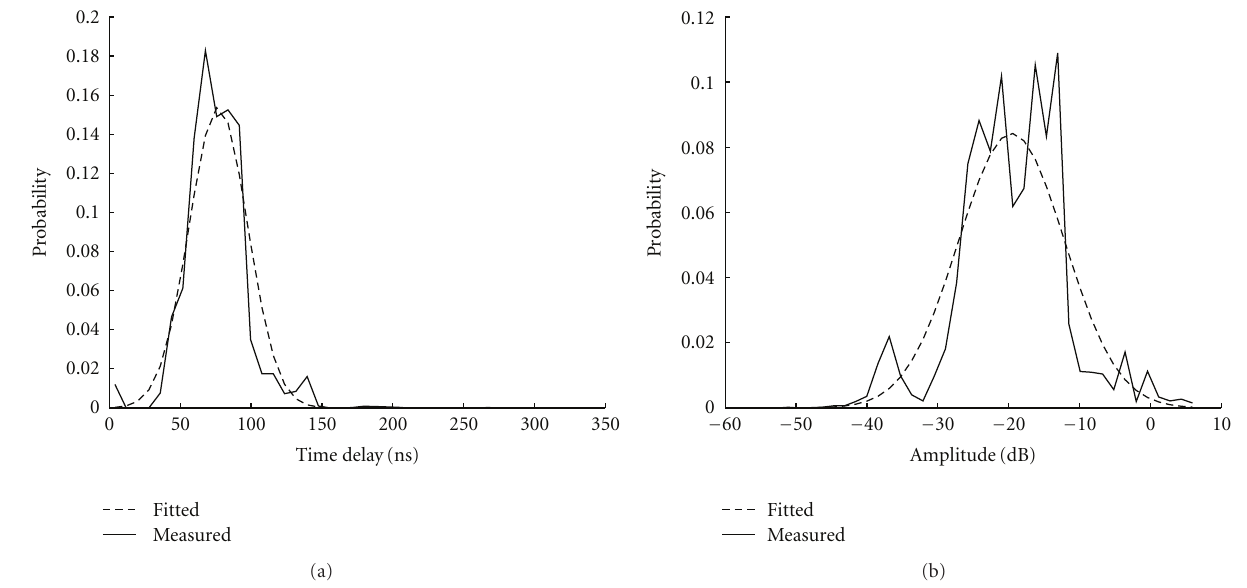
Figure 9: Probability distribution of (a) time of arrival ( τ ) and (b) amplitude ( α ) of multipath